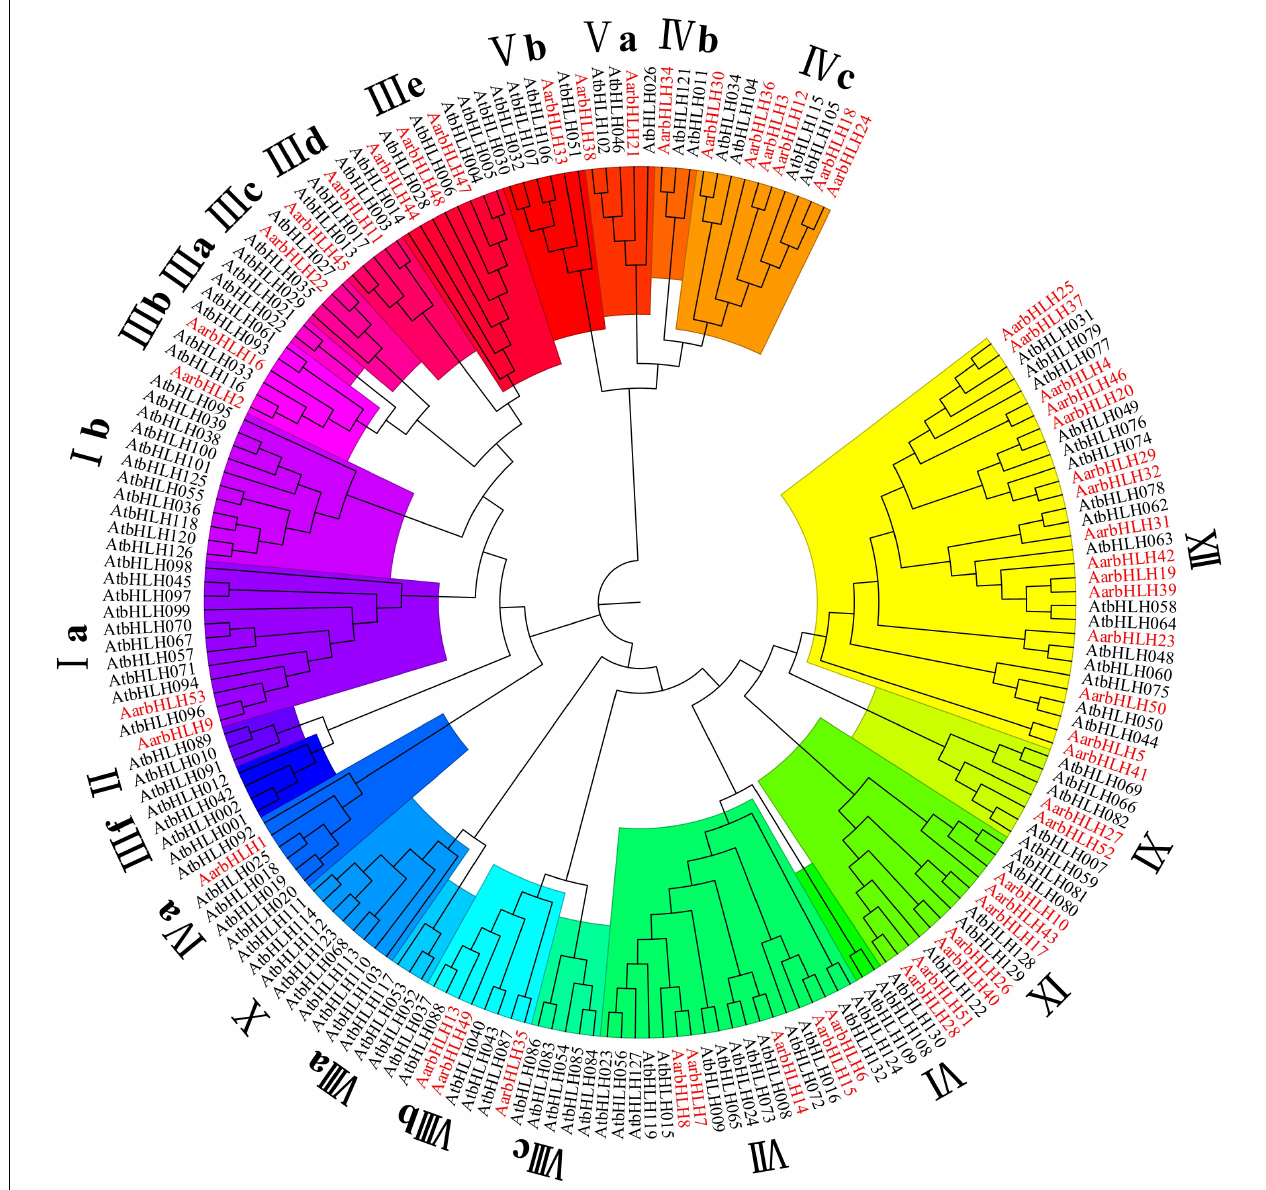
FIGURE 1 | The phylogenetic tree of bHLH proteins in Artemisia argyi and Arabidopsis thaliana. The tree was constructed using MEGA 7.0 with the Neighbor Joining-NJ method (bootstrap values for 1000 replicates). The colored branches indicate different subgroups. Red fonts represent AarbHLH proteins. Black fonts represent AtbHLH